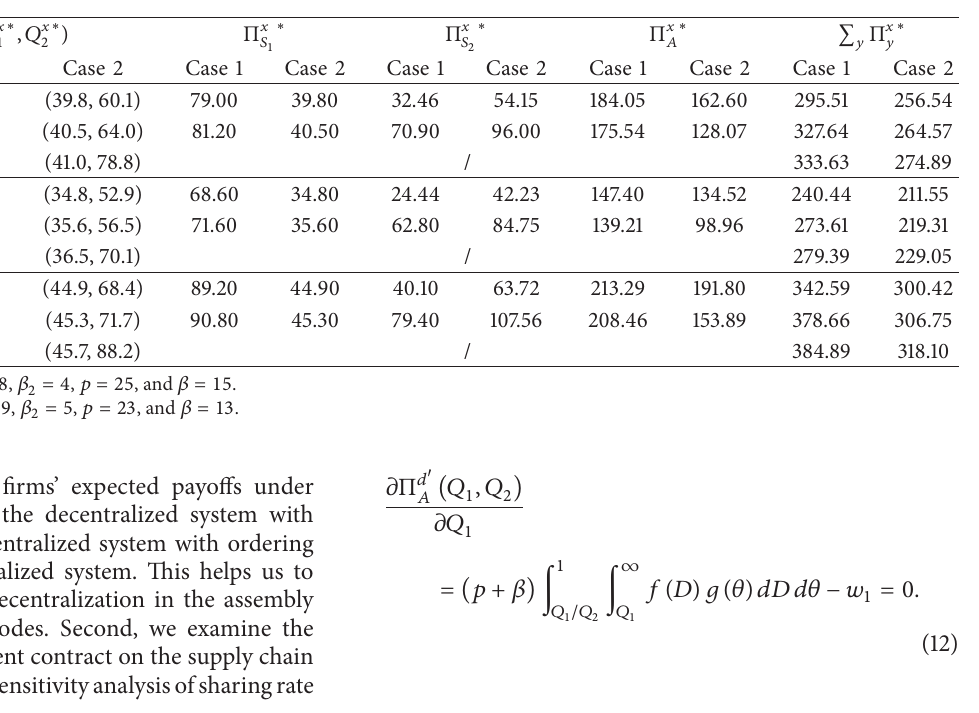
Table 1: Performance with different penalty, price, and